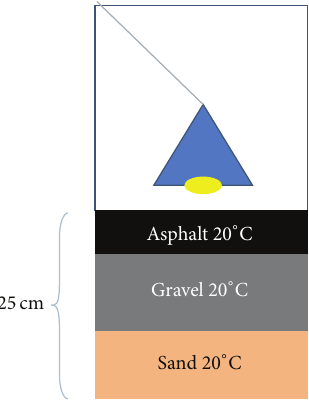
Figure1:Experimentallaboratoryset-upforasphaltmeasurements.